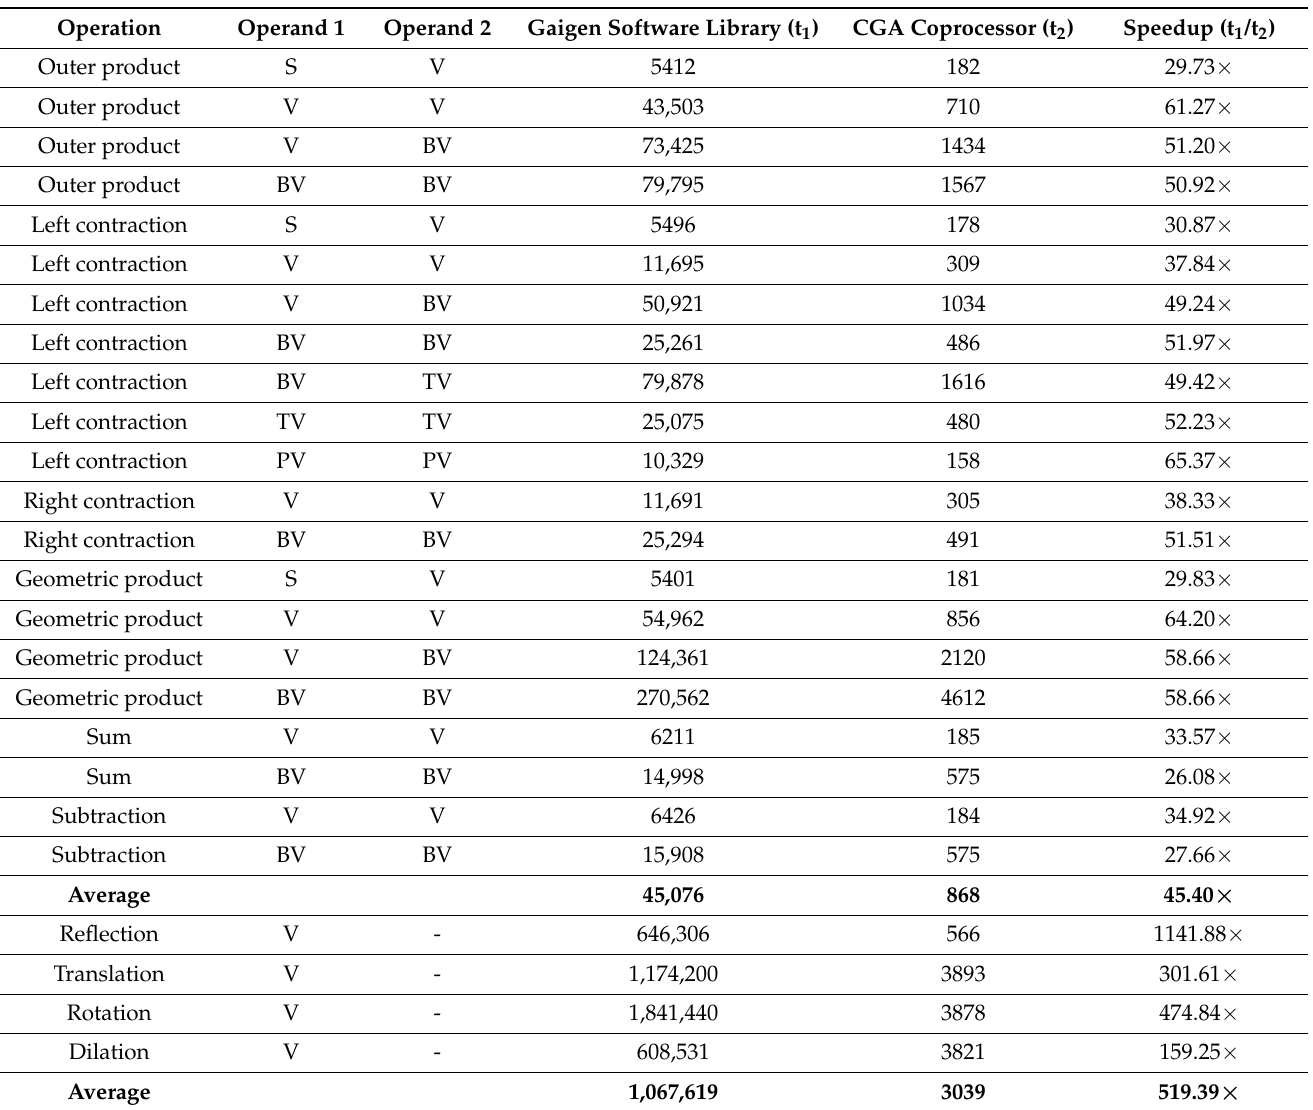
Table 7. Execution times measured in clock cycles at 125 MHz—Gaigen/CGA coprocessor compari- son (reported values are average values related to 10,000 executions of each operation on randomly generated